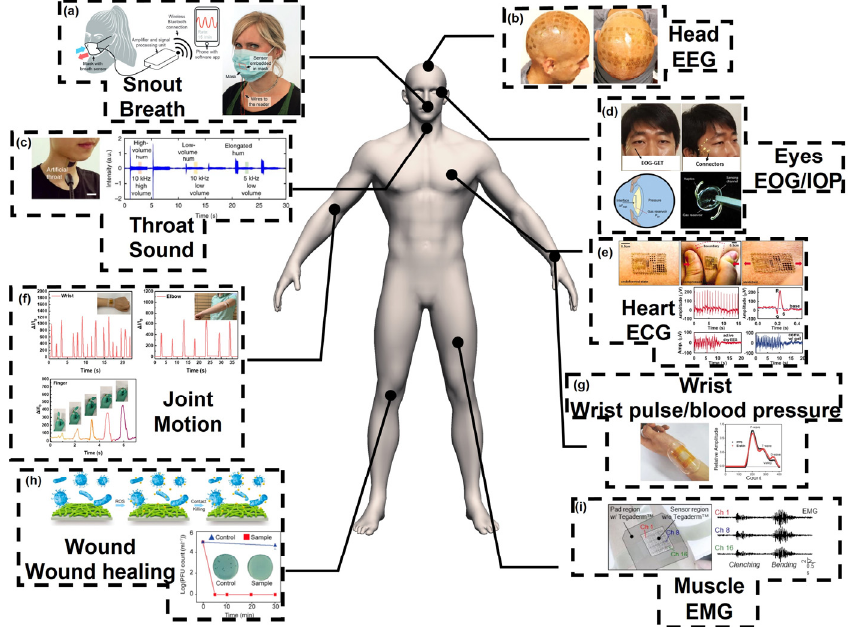
Figure 1. Wearable systems for human health monitoring, including ( a ) breath monitoring. Repro-